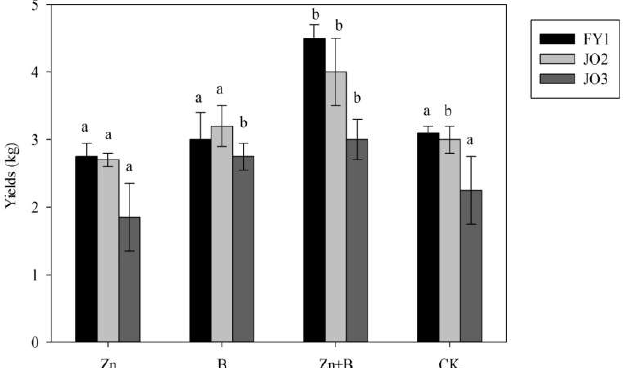
Figure 1. Effects of the foliar applications of the micronutrient solutions on the yield in L. cubeba (Lour.) Persoon. The different lowercase letters indicate significant differences ( p < 0.05) from the different foliar applications of the nutrient solutions. Identical letters indicate the absence of significant differences. The abbreviations of “ Zn ” , “ B ” , “ Zn + B ”, and “ CK ” represent ZnSO 4 , H 3 BO 4 , and ZnSO 4 + H 3 BO 4 , and the control. Error bars are standard errors. The same is as below. Table 3. Analysis of variance of yield, yield components, fruit oil content, and citral